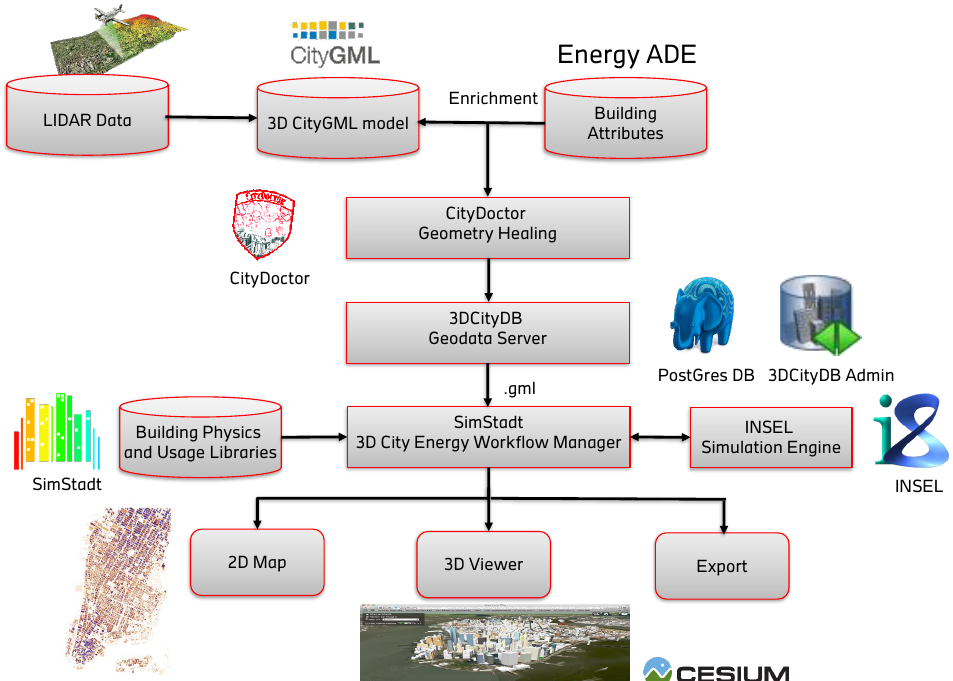
Figure 1. SimStadt simulation environment with data sources.